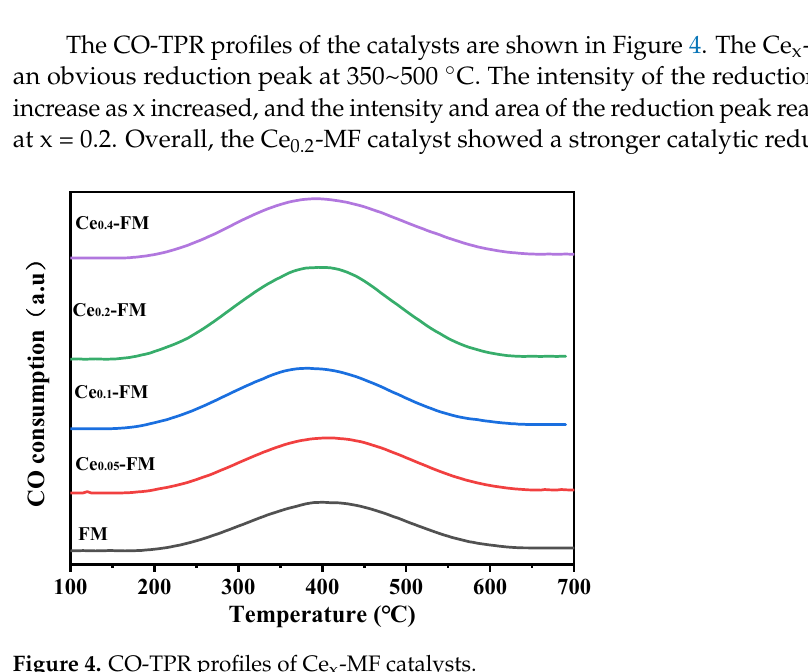
Figure 5. SEM images of the catalysts: ( a ) MF, ( b ) Ce 0.05 -MF, ( c ) Ce 0.1 -MF, ( d ) Ce 0.2 -MF, and ( e ) Ce 0.4 - MF.